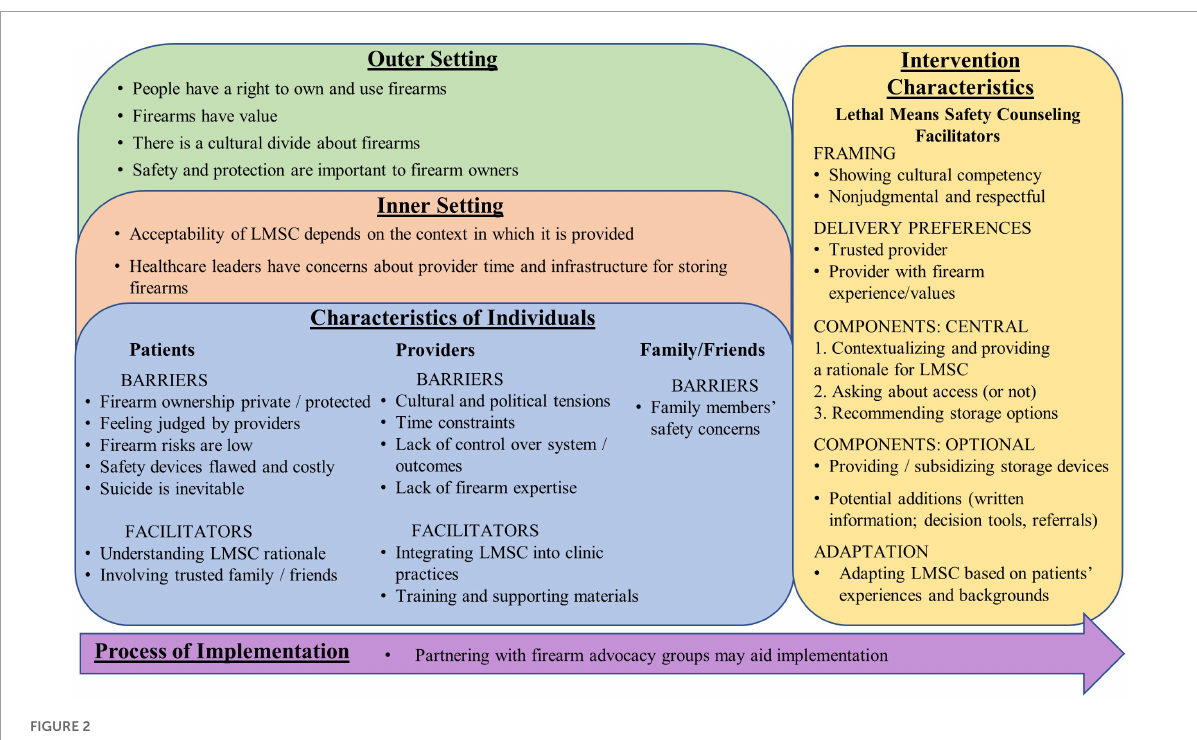
FIGURE2 Subthemes organized by CFIR (consolidated framework for implementation research)